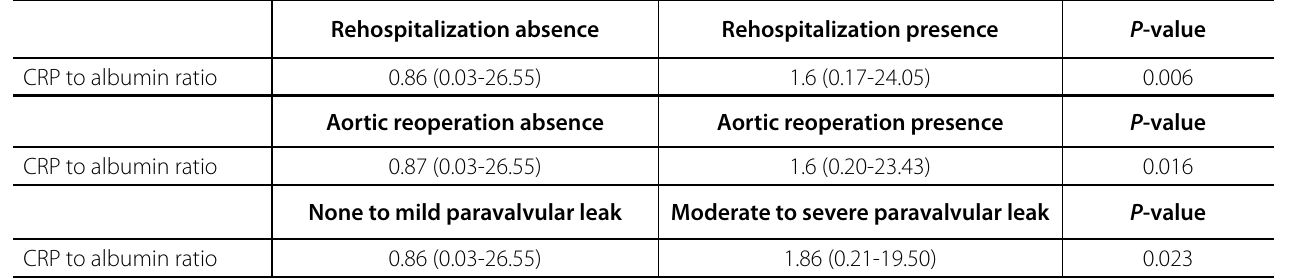
Table 3 . Comparison of CRP to albumin ratio in the presence and absence of rehospitalization, aortic reoperation, and moderate to severe paravalvular leak.